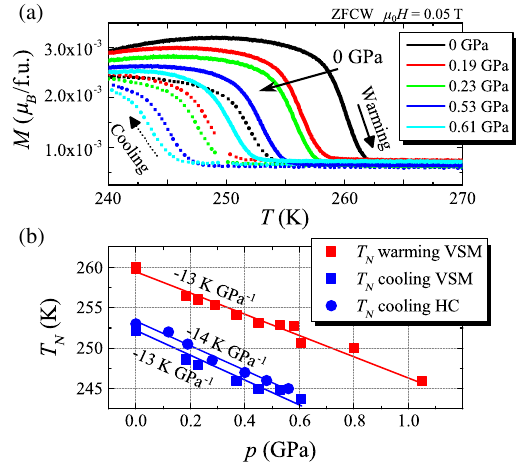
FIG. 2. (a) Magnetization under an applied field of μ 0 H ¼ 0 . 05 T as a function of the temperature and measured at different pressures after zero-field cooling. (b) Pressure dependence of T taken from the derivative of the M ð T Þ VSM data and the peak of the HC data. Solid lines are linear fits to the data.